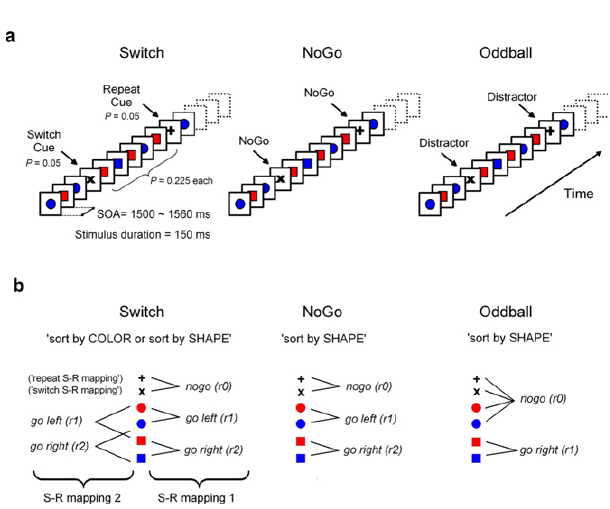
Figure 1. Experimental design and task-set information. (A) Stimulus material. All 3 tasks consisted of the same sequence of frequent colored shapes ( p = 0.9) with semi-randomly interspersed infrequent black sym- bols ( p = 0.05 for both ‘ + ’ and ‘ x ’ symbols). In the Switch task, symbols ‘ x ’ and ‘ +’ instructed subjects to switch and repeat the previous S–R mapping, respectively. The NoGo task consisted of two-forced response choices (i.e., ‘press button 1 for circles and button 2 for squares’), whereas the Oddball task involved one-forced response trials (i.e., ‘press button 1 for squares’). Subjects were explicitly instructed not to respond to the black symbols ‘ x ’ and ‘ + ’ in the NoGo and Oddball tasks. (B) Hypothetical task-set information and S–R map- pings. Task demands were manipulated (1) by varying the amount of task-set information to be handled in working memory (Oddball vs. NoGo tasks); and (2) by varying the contextual meaning of black symbols for updating the active S–R mappings (NoGo vs. Switch tasks; see Tables 1 and 2